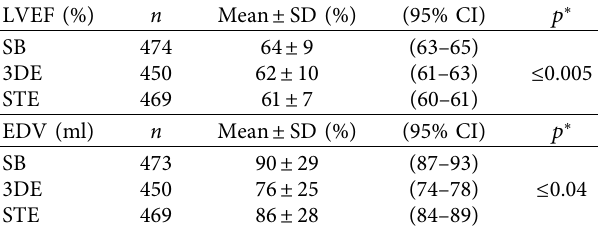
Good Moderate 179 (37.8%) Poor 23 (4.9%) Data are median and interquartile range or number (%). GLS: global longitudinal strain; LVEF: left ventricular ejection fraction; EDV: end di- astolic volume; SB: Simpson’s biplane method; 3D: three-dimensional echocardiography; STE: speckle tracking echocardiography; LVM: left ventricular mass. Table 2: Mean LVEFs and EDVs obtained by the different